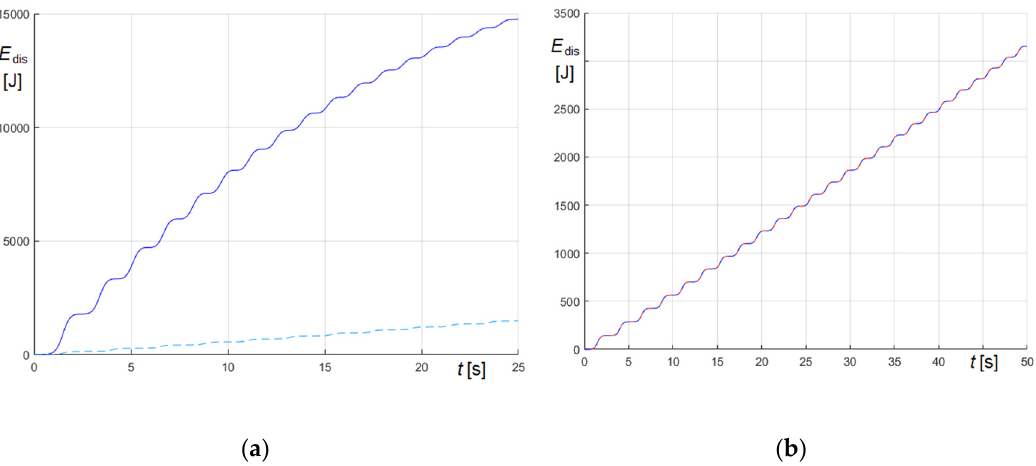
Figure 21. Energy dissipation − time curves for friction (dashed lines) and “equivalent” viscosity (solid lines) for large oscillations of St. Mary’s tenor bell ( θ 0 = 171 ◦ ) : ( a ) “5 ◦ equivalent” viscosity parameters; ( b ) “171 ◦ equivalent” viscosity parameters.